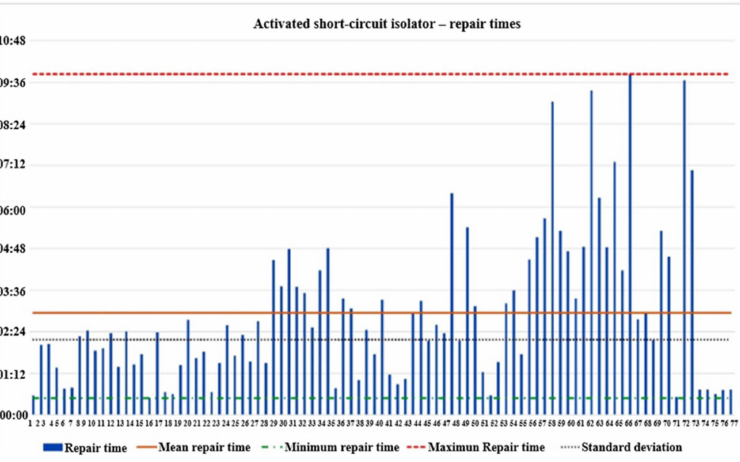
Figure 5. Repair times: activated short-circuit isolator. Test results: mean repair time 176 min, minimum repair time 29 min, maximum repair time 590 min, repair time standard deviation 129